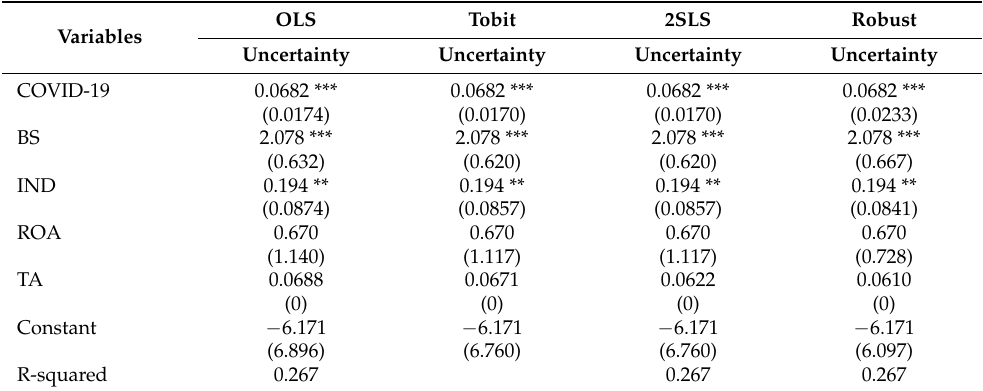
Table 4. Regression